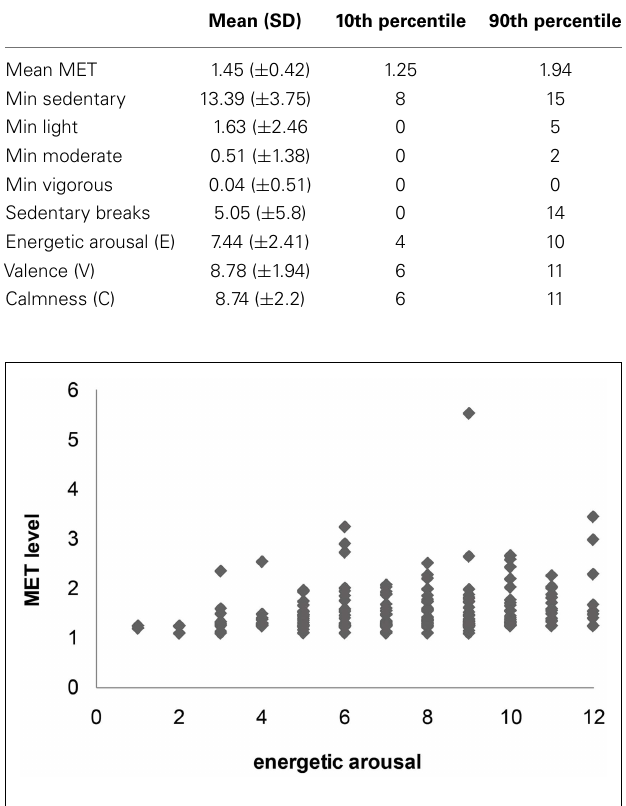
FIGURE 1 | Scatter plot of E (energetic arousal) score and activity intensity (mean MET level during 15min